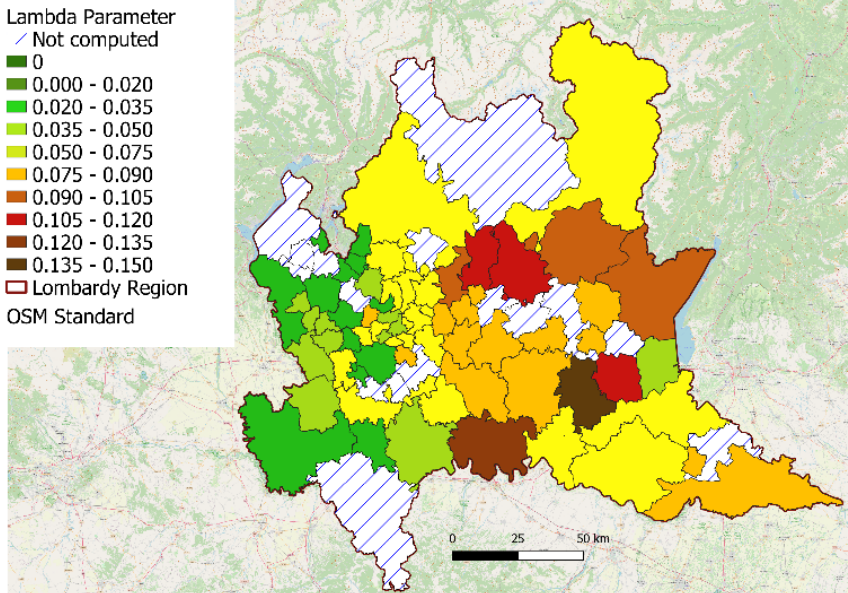
Figure 5. Values of the lambda parameter ( λ d ), which was used as an estimator of the speed of COVID-19 diffusion on the basis of ambulances dispatched for respiratory issues (see text for details) for each district of approximately 100,000 residents, mapped on the territory of the Lombardy region (Italy).